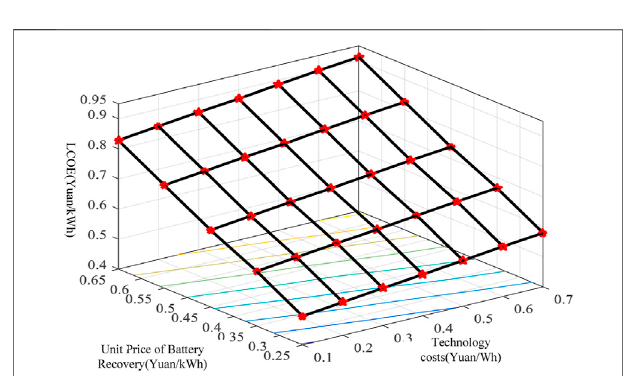
FIGURE 5 | K = 2,000 times sensitive cost parameter relationship.